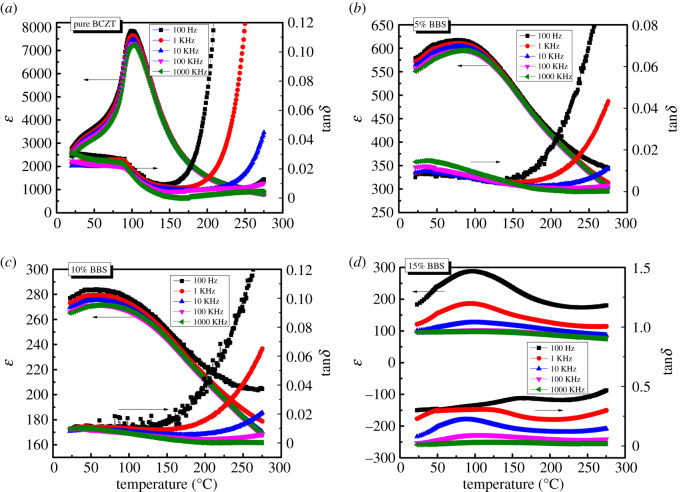
Temperature dependence of the dielectric constant and dielectric loss for the (1 − x)BCZT-xBBS glass ceramics. (a) x = 0, (b) x = 0.05, (c) x = 0.1, (d) x = 0.15.